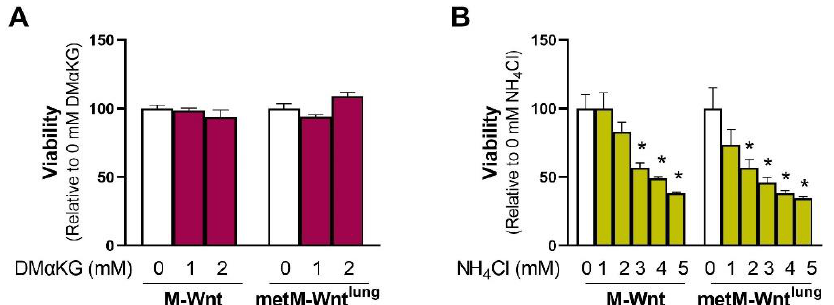
Figure 3. Effect of dimethyl α -ketoglutarate and ammonium chloride on cell viability. ( A ) The effect of exogenous addition of a membrane-permeable form of α -ketoglutarate (dimethyl α -ketoglutarate, DMαKG) or ( B ) ammonium chloride (NH 4 Cl) on viability was assessed in cells constitutively grown in 2 mM glutamine. Results are expressed as means + SEM. Asterisk (*) indicates p < 0.05 relative to 0 mM ammonium chloride ( B ).